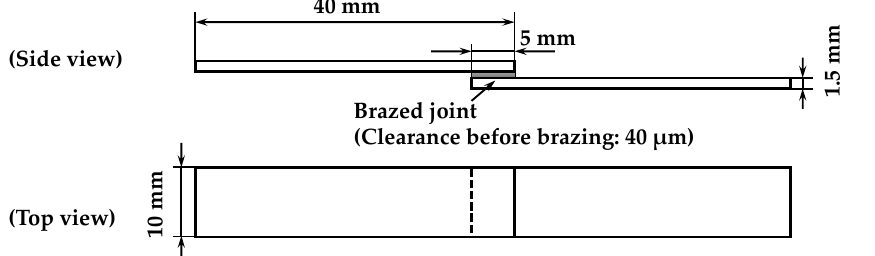
Figure 2. Geometry and dimensions of brazed joint specimen.